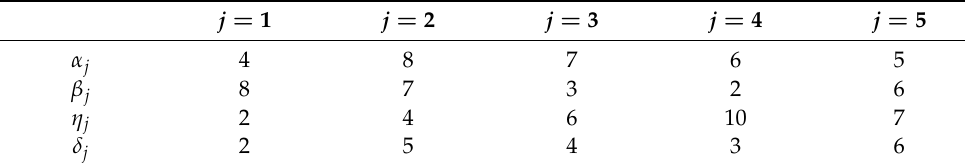
Table 2. Values of position-dependent weights.